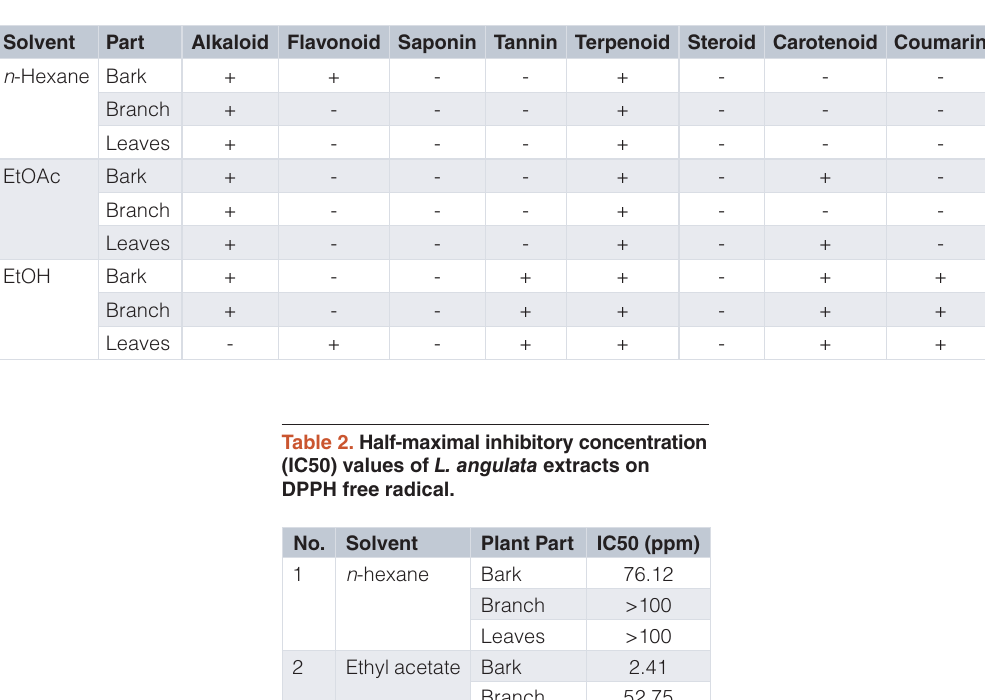
Table 1. Secondary metabolites in L. angulata extracts.